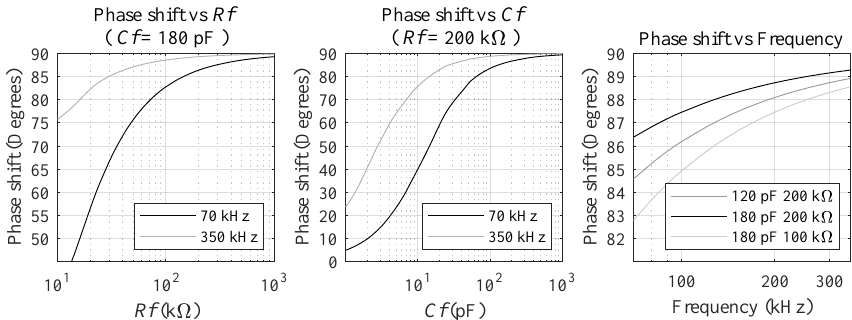
Figure 3. The relationship between phase shift degree and R f , C f ,